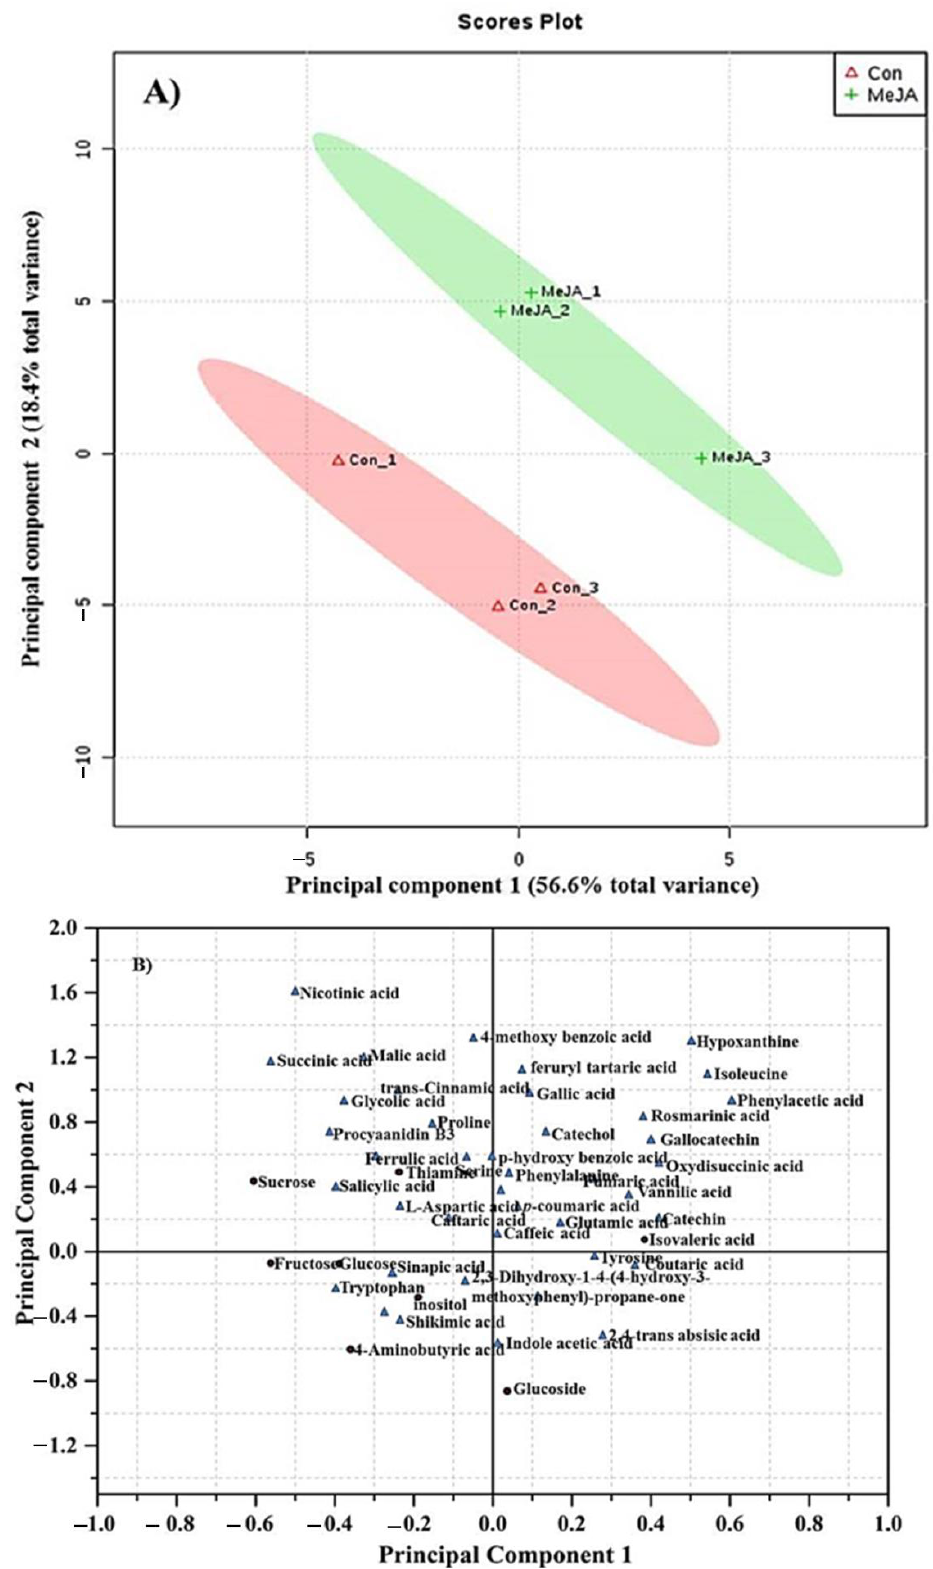
Figure 2. PLS-DA results of score ( A ) and loading plots ( B ) of principal component 1 and 2 for polar metabolites data obtained from MeJA-treated cells and control cells of H. Pinifolia.